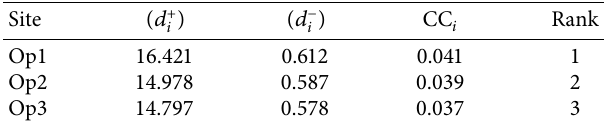
Table 28: The final ranking of the selected wind sites.